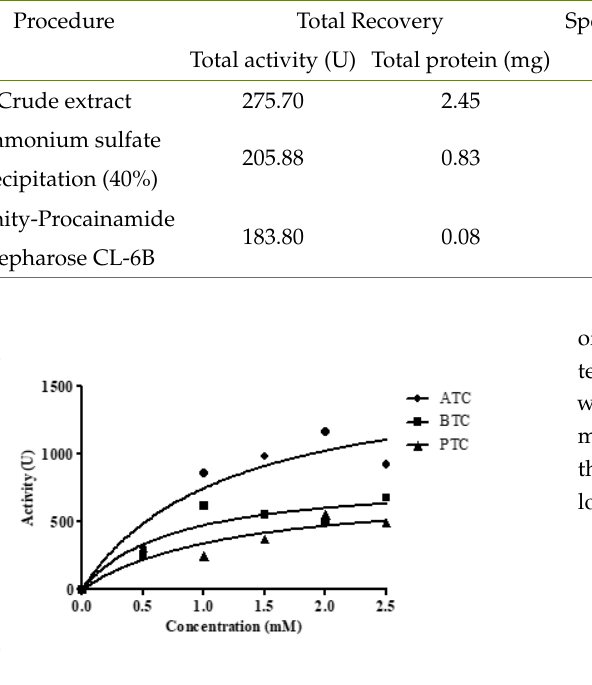
Fig. 2. The substrate specificity of D. hystrix AChE brain in 0 to 2.5 mM acetylthiocholine iodide, butyrythio- choline iodide and propionylthiocholine iodide, respec- tively. Data represented in mean ± standard deviation (n=3). Table 2. Kinetic table of biomolecular constant (K m ) and maximal velocity (V max ) for ATC, BTC and PTC of Diodon hystrix AChE.